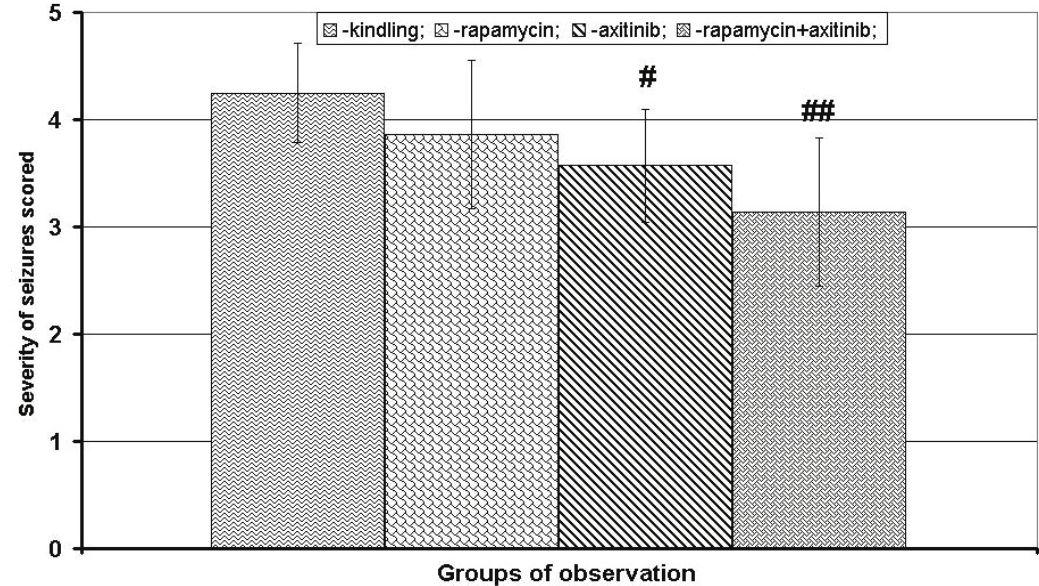
Fig. 4. Kindled seizure severity estimated after ten days of treatment with rapamycin and axitinib. The data average is expressed as M + SEM. Kriskal-Wallis test, followed by Dunn test, was used for comparison # – P <0.05 and ## – P <0.01 vs. kindled